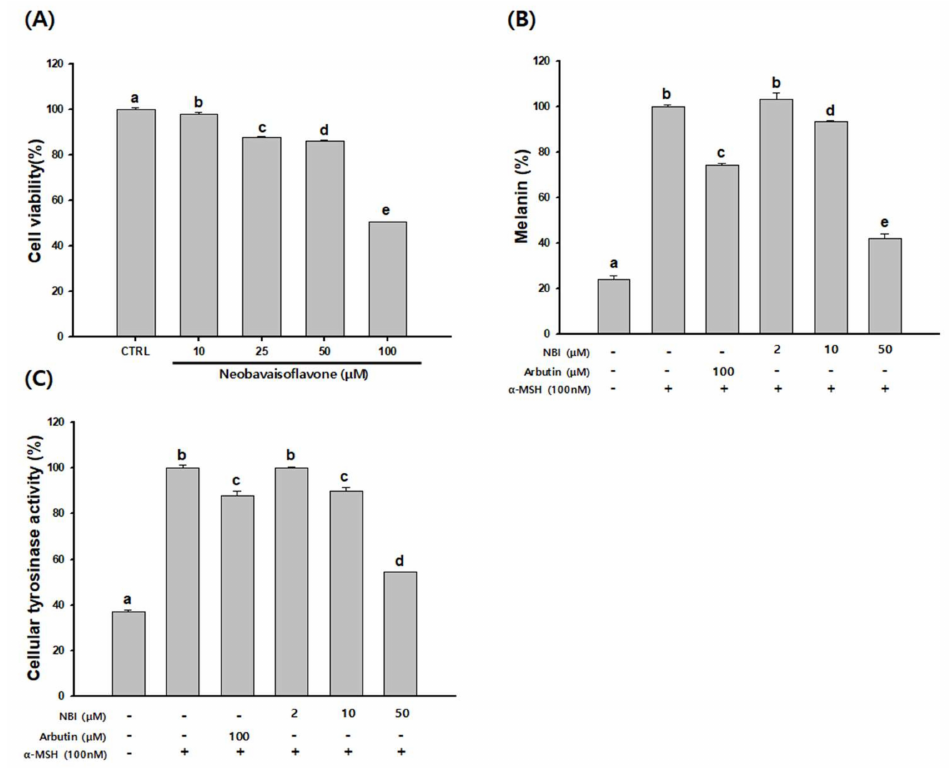
Figure 4. E ff ects of NBI on anti-melanogenesis in B16F10 cells. Cells were cultured with NBI (2–50 µ M) for 48 h. ( A ) Cytotoxicity, ( B ) melanin contents, and ( C ) cellular tyrosinase activity were measured. Data are presented as mean ± SD. Values with di ff erent letters (a, b, c, d, e) are significantly di ff erent one from another (one-way ANOVA followed by Tukey’s multiple range test, p <